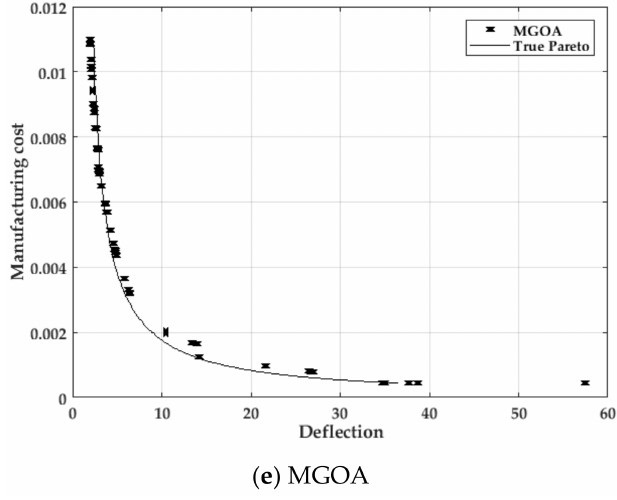
Figure 18. Obtained Pareto fronts versus True—fronts of the developed MGWO, NSGA II, MFPA, MOLA, and MGOA for WBD under third case.